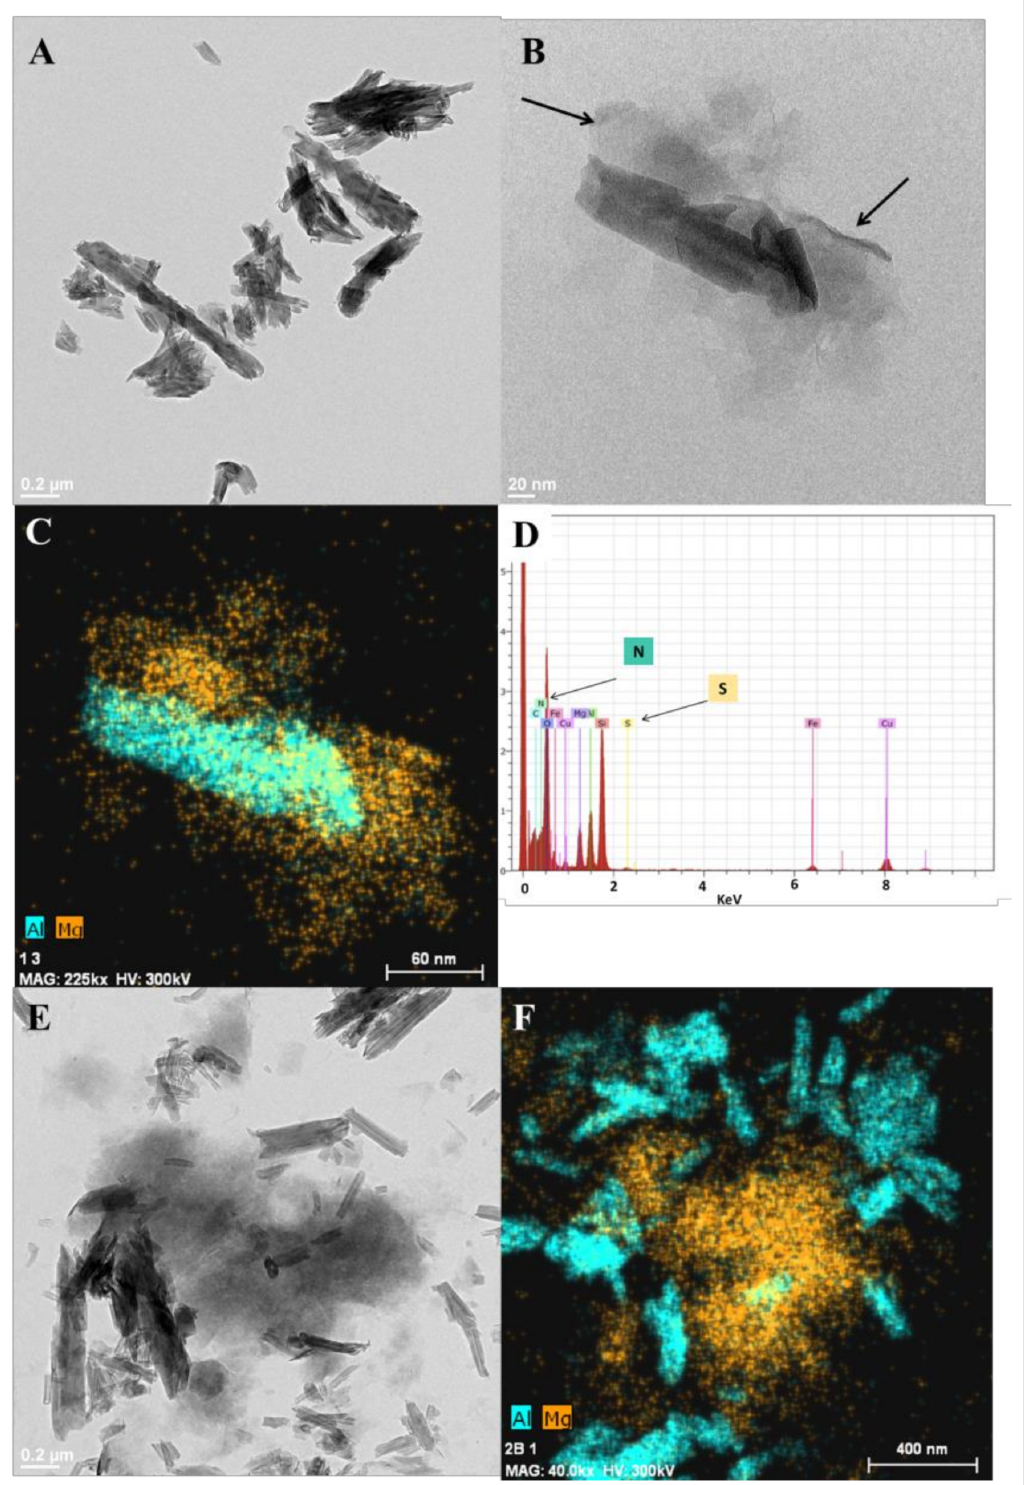
Figure 3. ( a , b ) TEM image of HNTs-Ht nanomaterial (scale bar 200 and 20 nm, respectively); ( c ) corresponding EDX image of Al and Mg from STEM image (scale bar 60 nm); ( d ) EDX spectrum of the HNTs-Ht nanomaterial; ( e ) TEM image of the physical mixture constituted by HNTs and Ht (scale bar 0.2 µ m); and ( f ) the corresponding EDX image of Al and Mg from STEM image (scale bar 0.4 µ